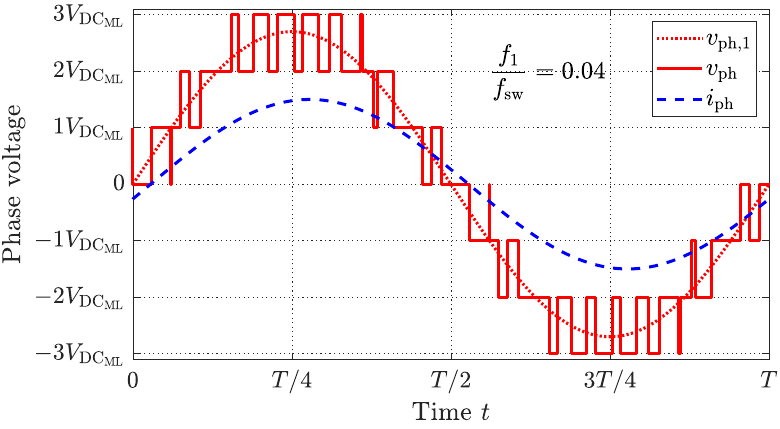
Figure 4. Output voltage modulation using PD-PWM for M = 0.9 and f 1 / f sw =